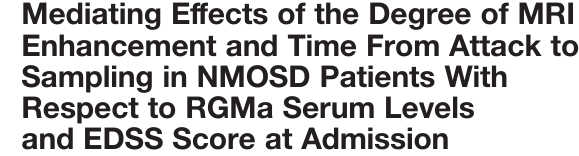
FIGURE 2 | Comparison of serum RGMa levels according to MRI enhancement.